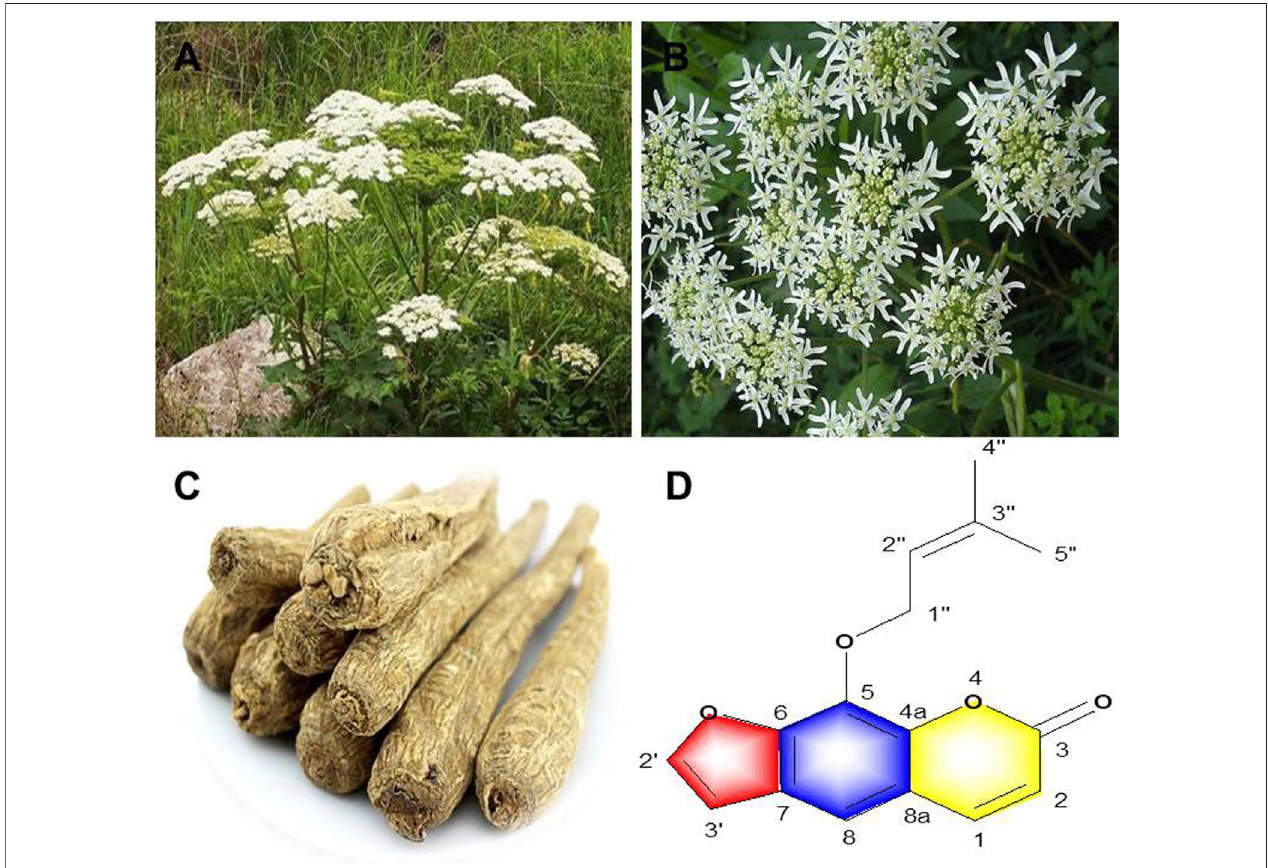
FIGURE 1 | A. dahurica : (A) aerial parts (B) fl owers (C) roots (D) chemical structure of